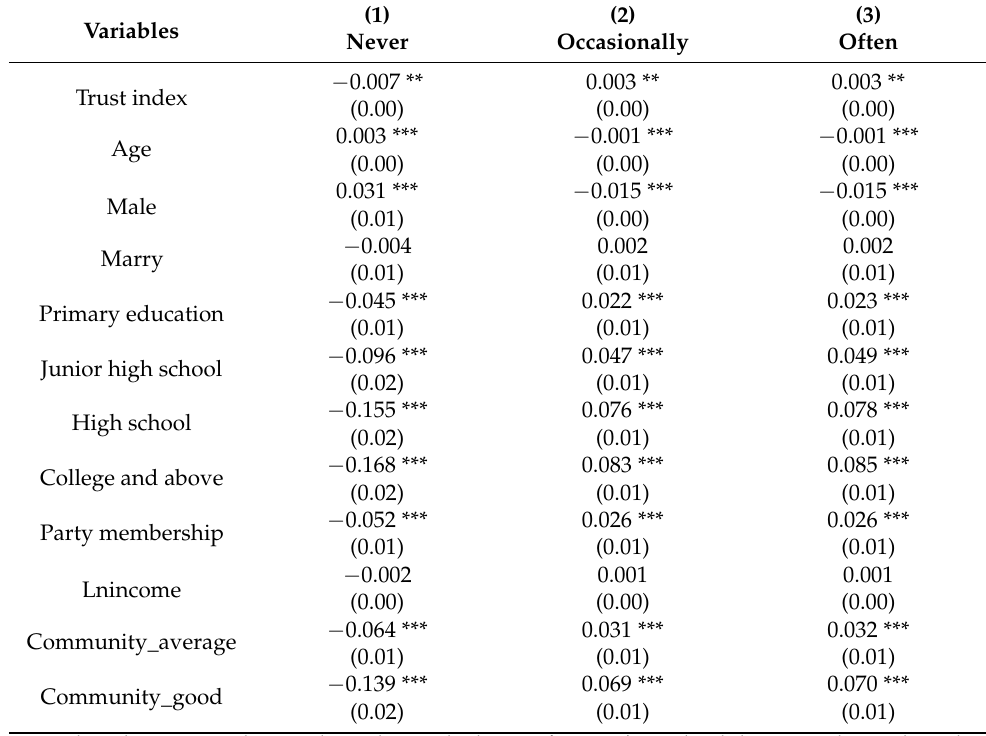
Table A8. Marginal Effects of Social Trust on Waste-Separation Behavior.